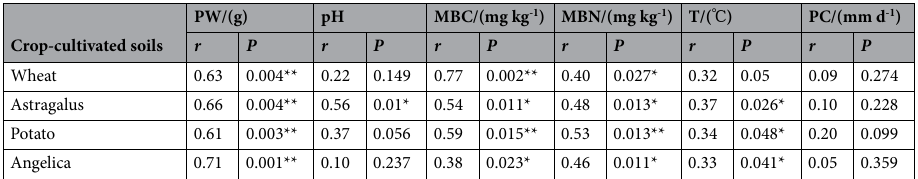
Table 3. Correlations between fungal microbiota and ecological factors based in crop-cultivated soils. Asterisk represented statistically significant differences between fungal microbiota and ecological factors by Mantel test at P < 0.05 (*) and 0.01 (**). The meanings of PW, pH, MBC, MBN, T and PC were illustrated in Table 1. r , the correlation of two matrices.